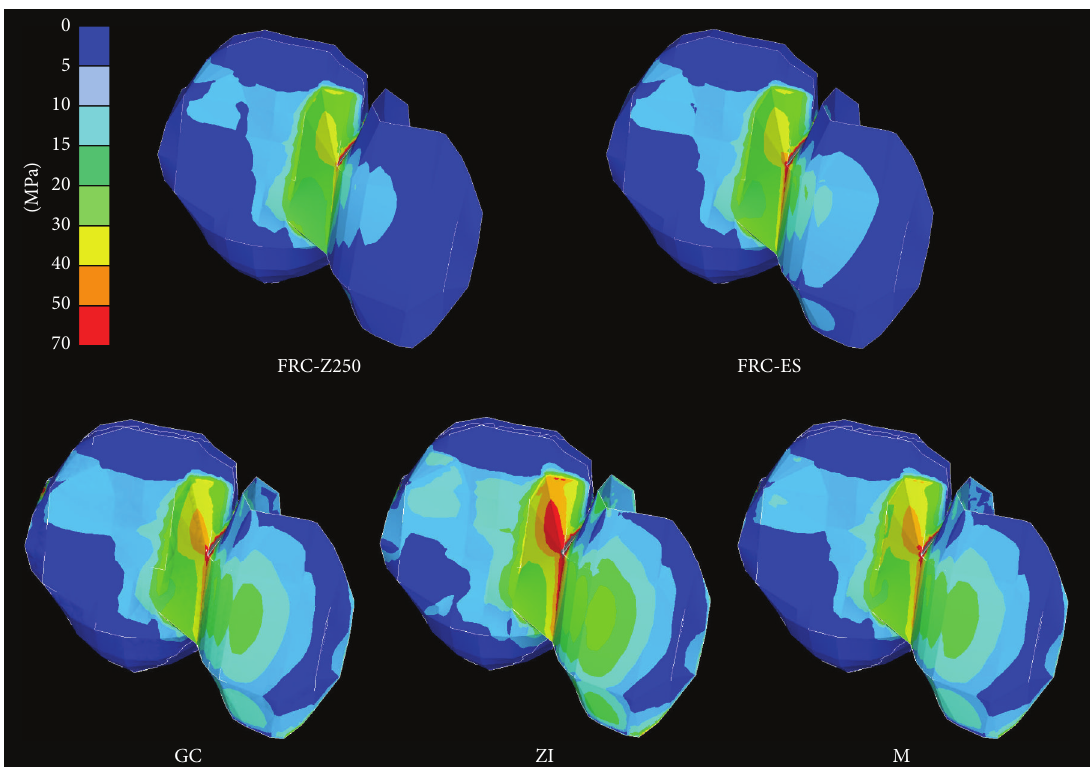
Figure 4: Principal stress distribution within two-unit cantilever RBFDPs of various framework